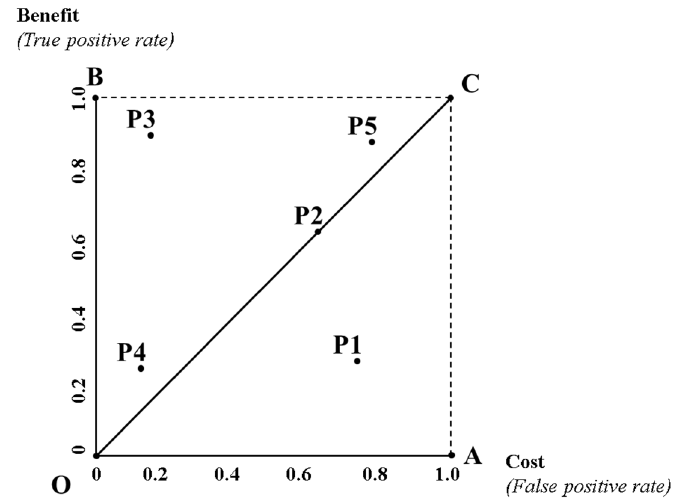
Figure 3. ROC graph and explanations of classifier positions.